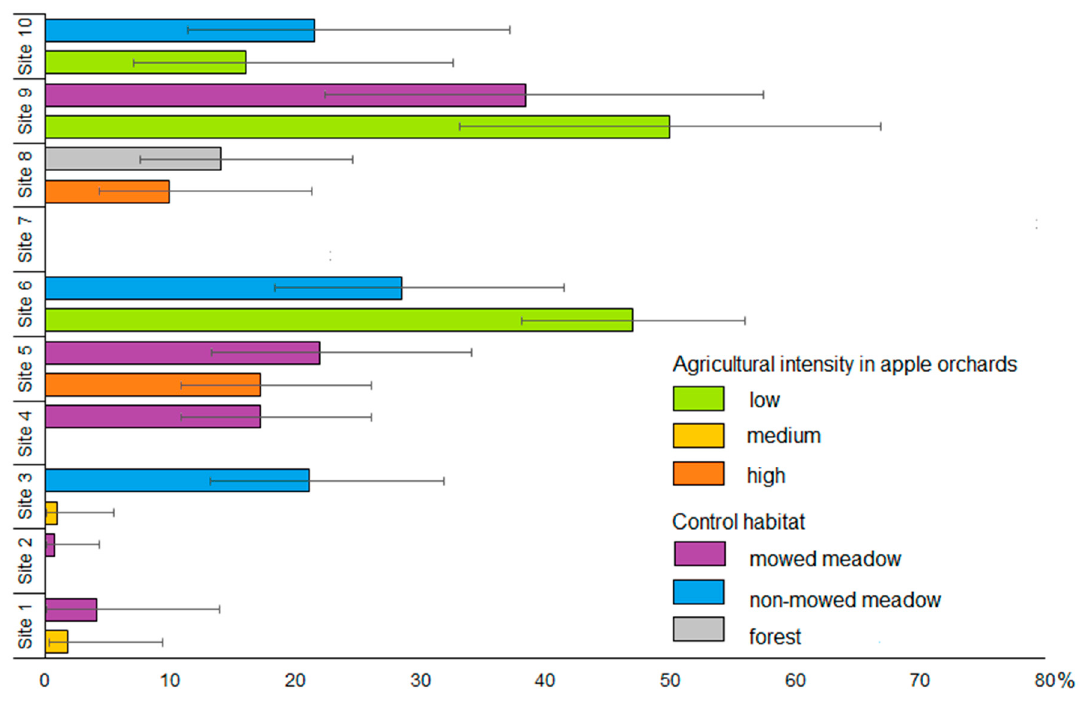
Figure 2. Proportion of C. glareolus in all trapped small mammals according to habitat (95% CI represented by error bars).